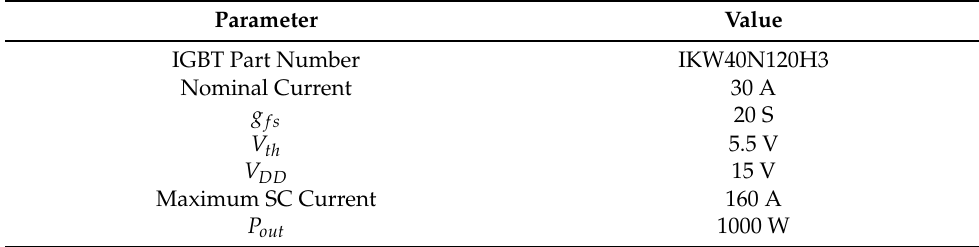
Table 1. The specifications of the considered case for current limiting.